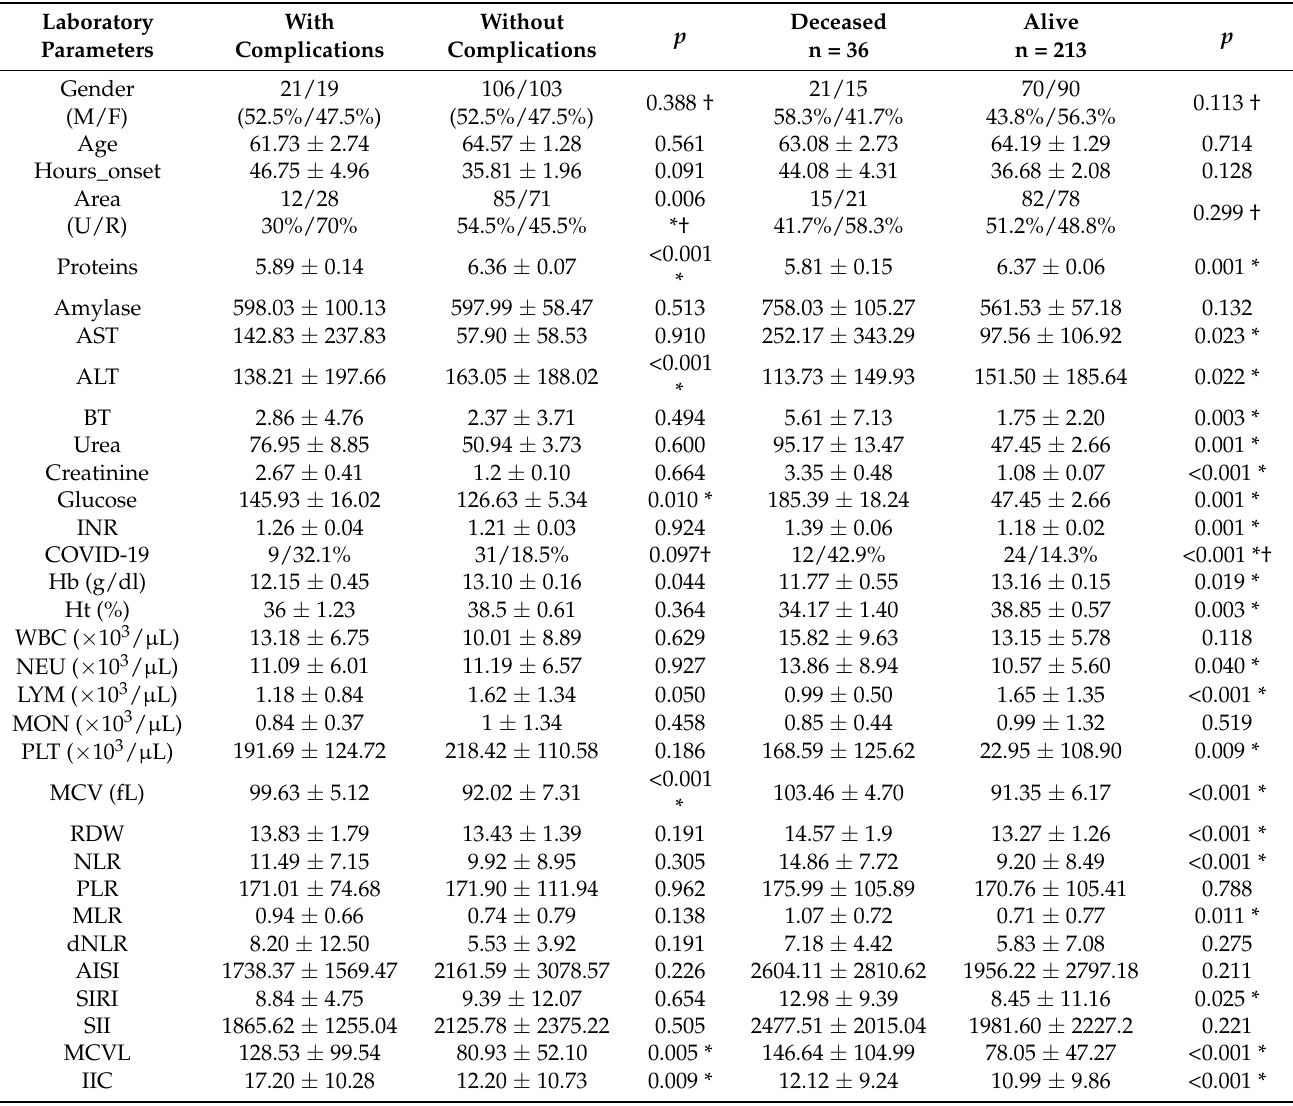
Table 6. Comparison of patients parameters according to complications and mortality in the peri- COVID